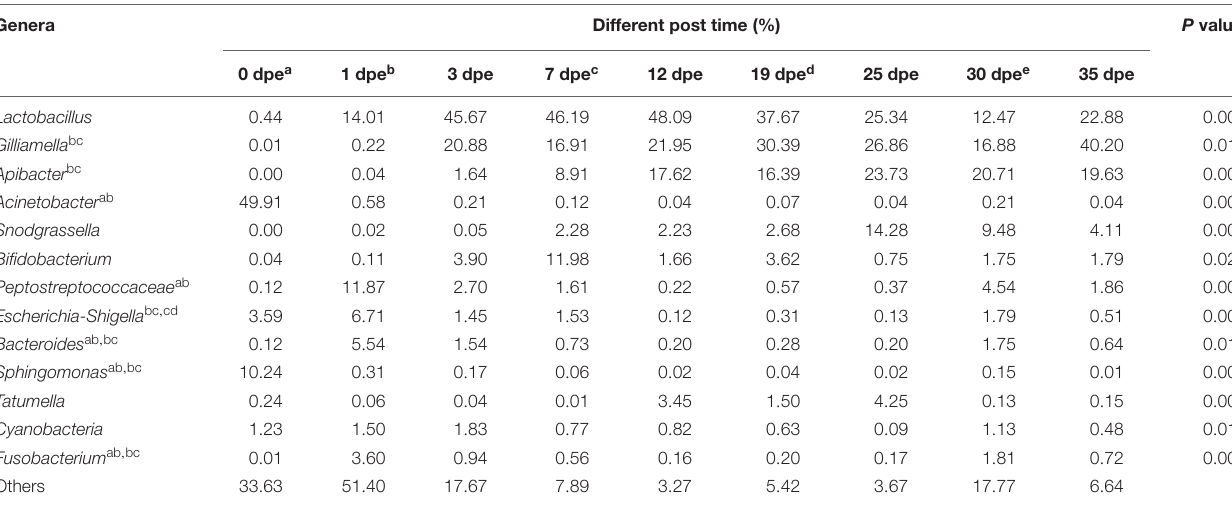
FIGURE 1 | (A) The abscissa is the sample name, and the ordinate is the proportion of species in the sample. The column of different colors represents different species, and the length of the column represents the proportion of the species. (B) The abscissa is the name of the sample, and the ordinate is the name of the species. The abundance of different species in the sample is shown by the color gradient of the color block. The right side of the figure is the value represented by the color gradient. TABLE 3 | Top 13 abundant